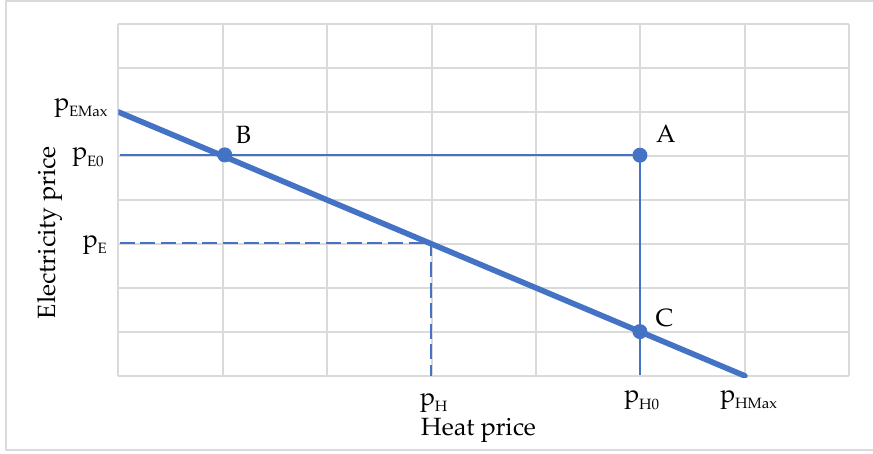
Figure 3. Heat and electricity prices of the combined heat and power (CHP) plant.